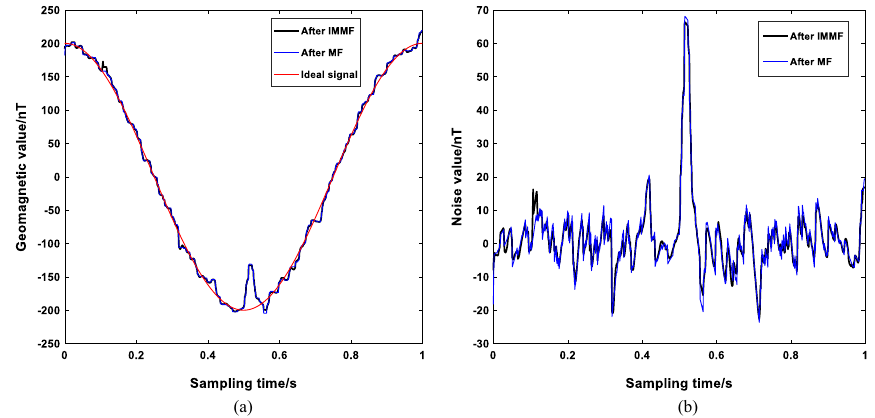
Fig. 5 The ideal signal and processed signal after second IMMF and MF based on triangle structure element